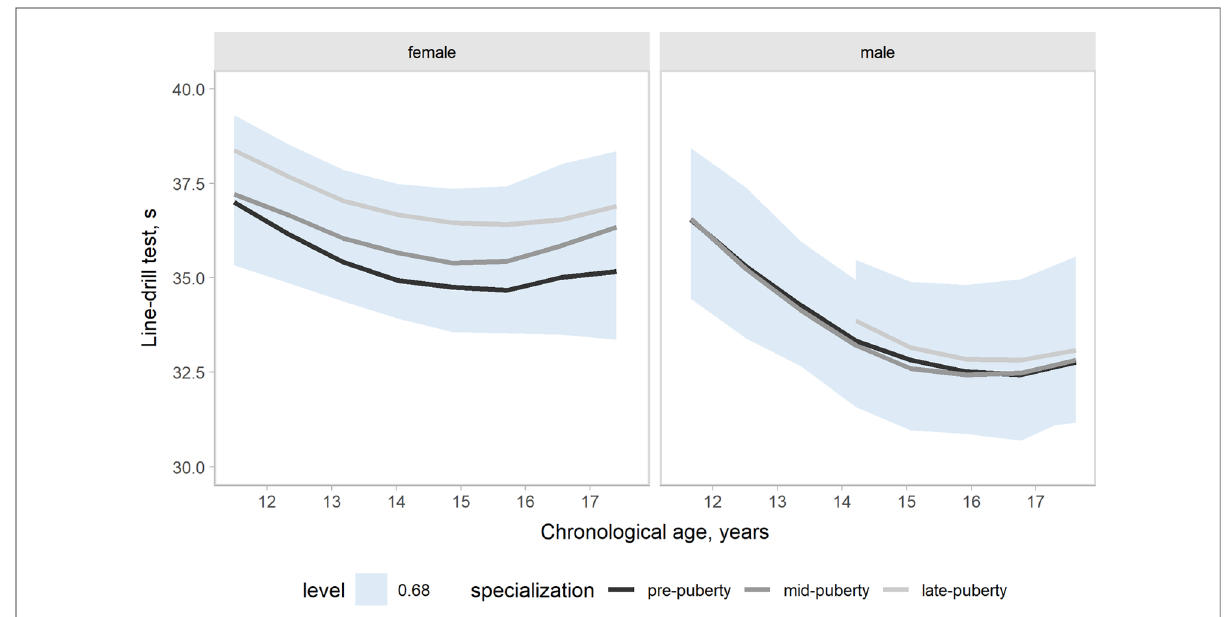
FIGURE 6 Developmental changes in line-drill performance for young females and male basketball players by specialization onset. The shaded area represents the 68% credible interval, similar to a standard